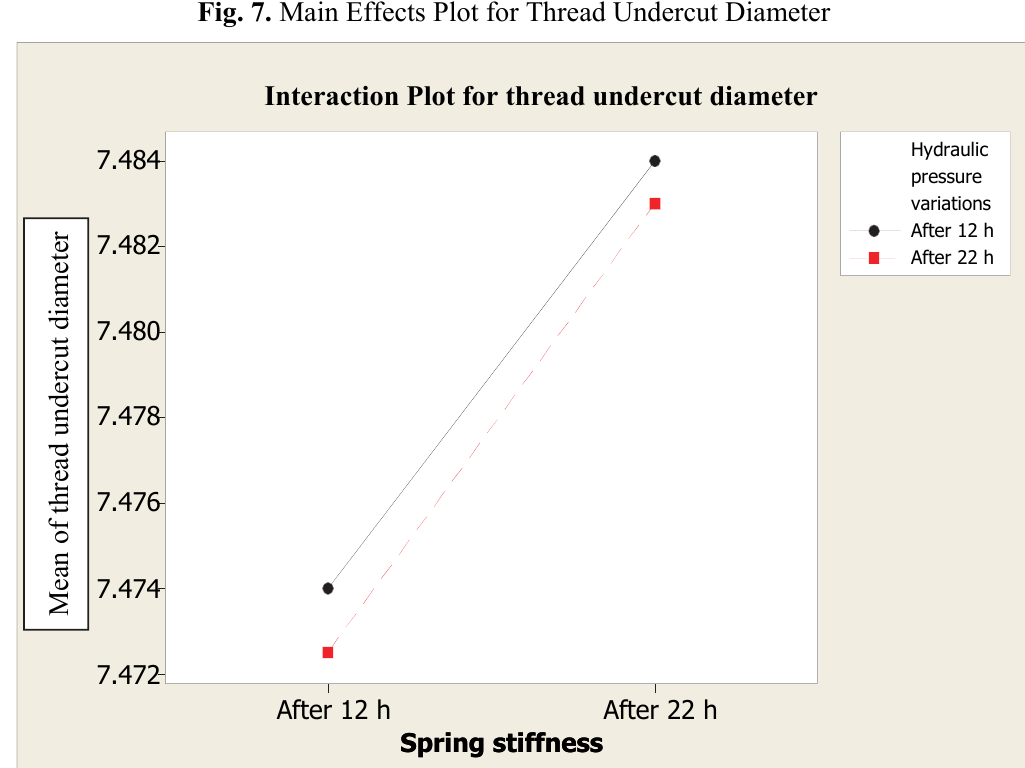
Fig. 8. Interaction Plot for Thread Undercut Diameter